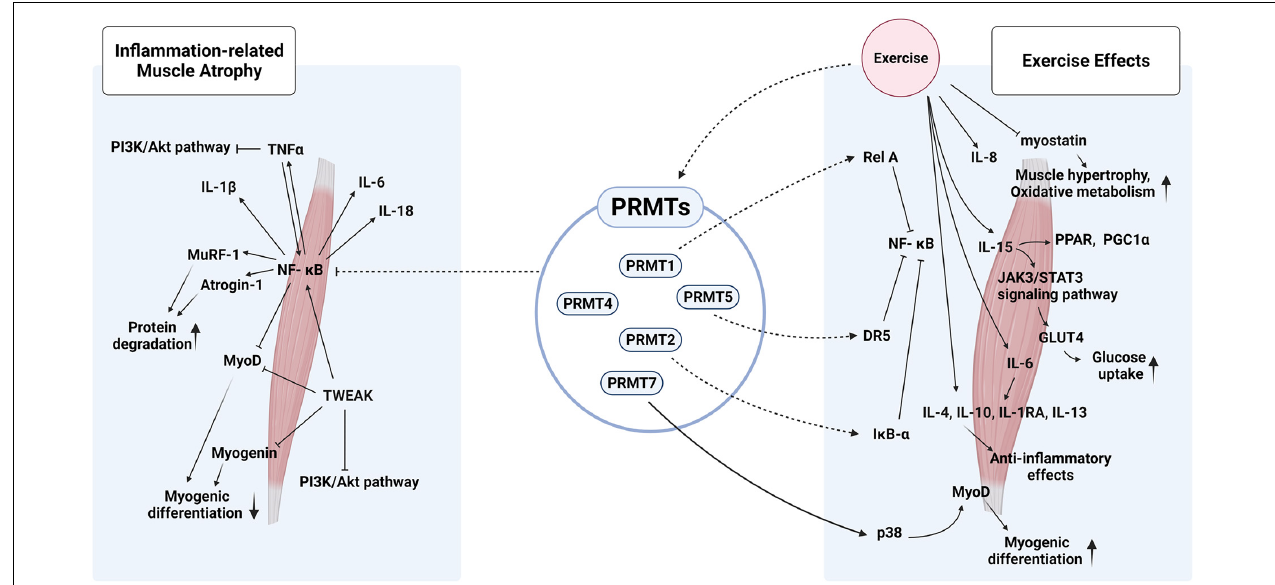
FIGURE 2 | Hypothetical roles of PRMTs in inflammation-related muscle atrophy and exercise-mediated effects on muscle metabolism and hypertrophy. PRMTs could modulate the activities of NK- κ B via multiple mechanisms to fine-tune the inflammatory responses triggered by pro- and anti-inflammatory cytokines in response to